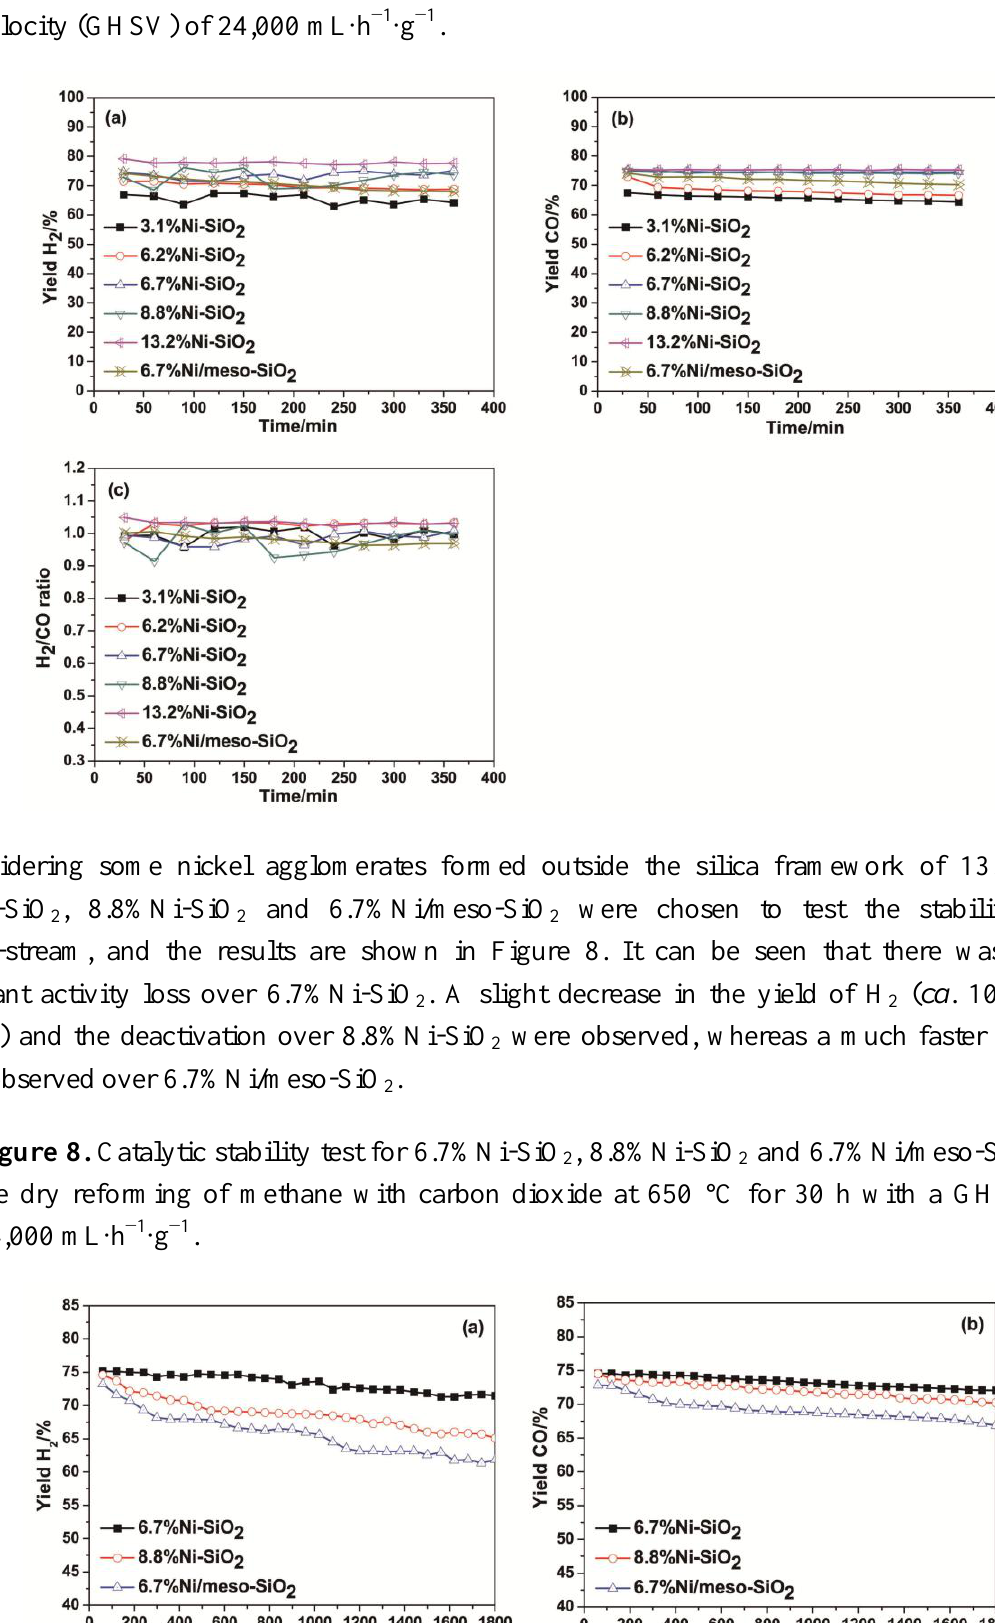
, ( b ) CO and ( c ) H /CO ratio in 2 2